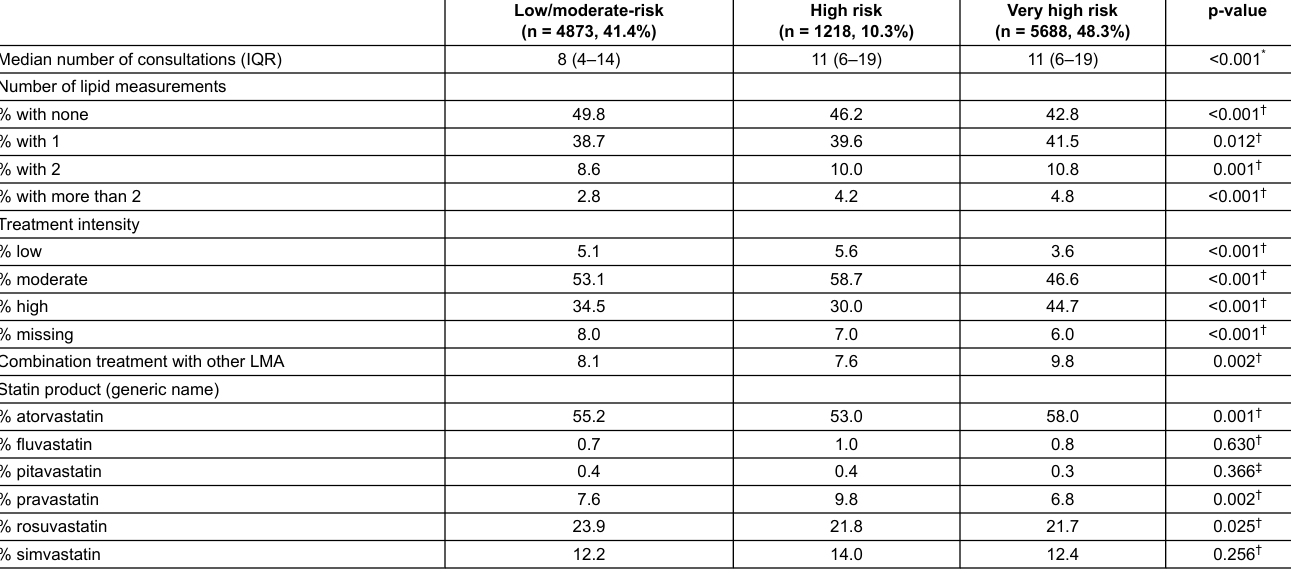
Table 2: Treatment strategy by cardiovascular